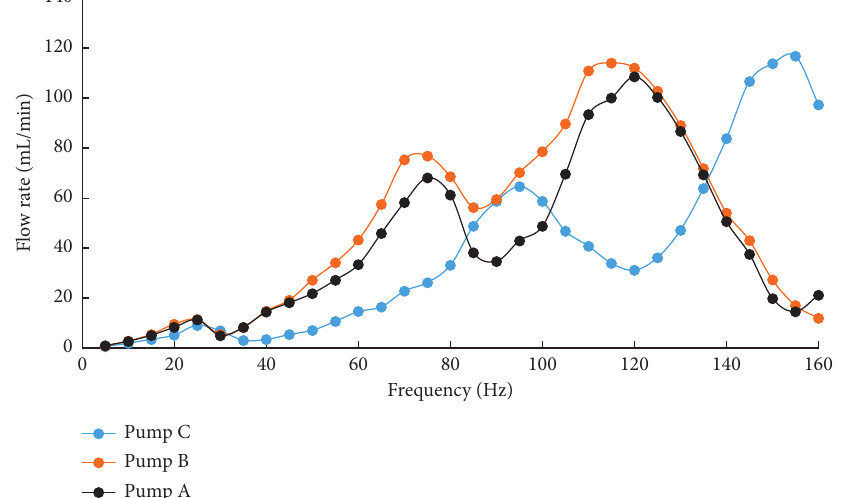
Figure 7: The flow rate measuring results of the pumps.